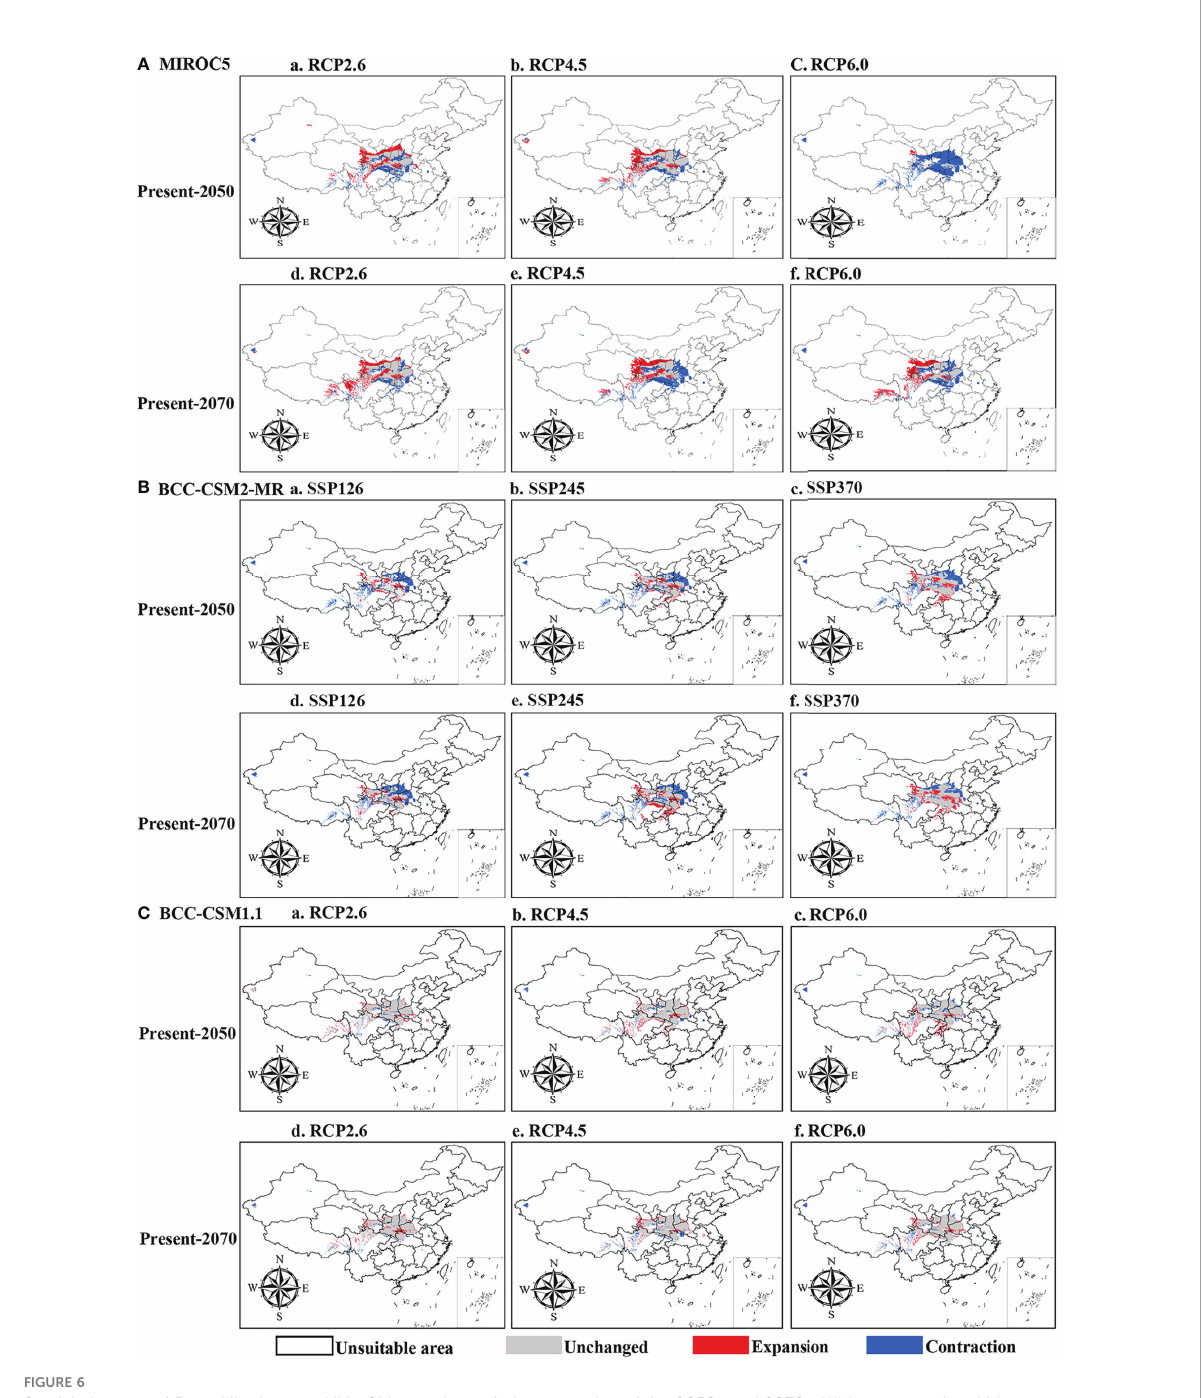
FIGURE 6 Spatial changes of P . rockii subsp. rockii in China under emission scenarios of the 2050s and 2070s. White, gray, red and blue areas represent not suitable, unchanged suitable, expansion suitable, and contraction suitable areas,